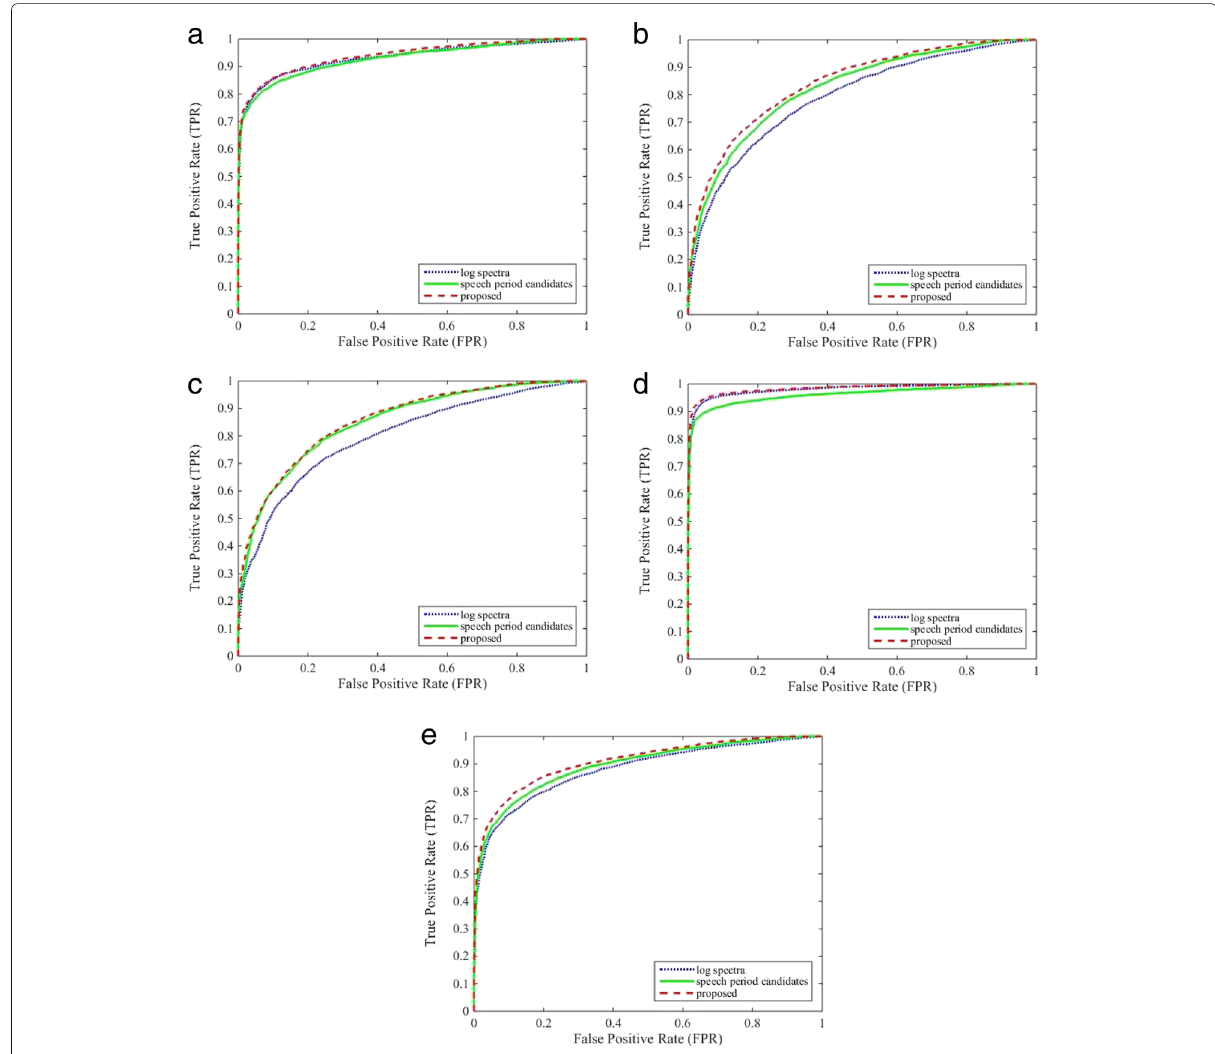
Fig.10 ROC curves for the proposed method and for DNN-based VAD methods using log power spectra and speech period candidates, respectively. a White noise, SNR = − 5 dB. b Babble noise, SNR = − 5 dB. c Factory noise, SNR = − 5 dB. d Car noise, SNR = − 5 dB. e Pink noise, SNR = − 5